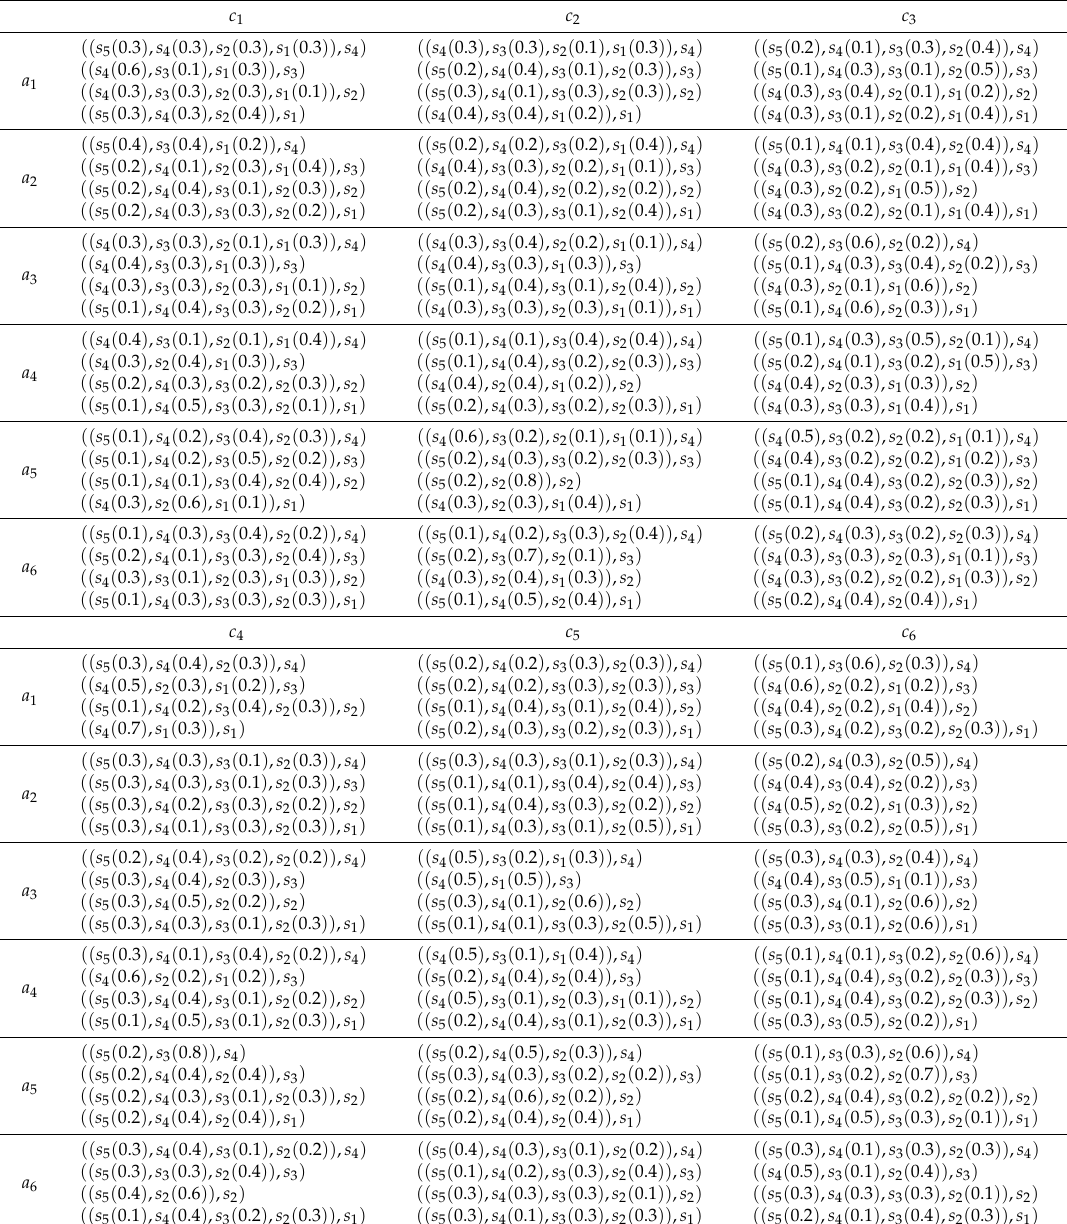
Table A1. The original evaluation